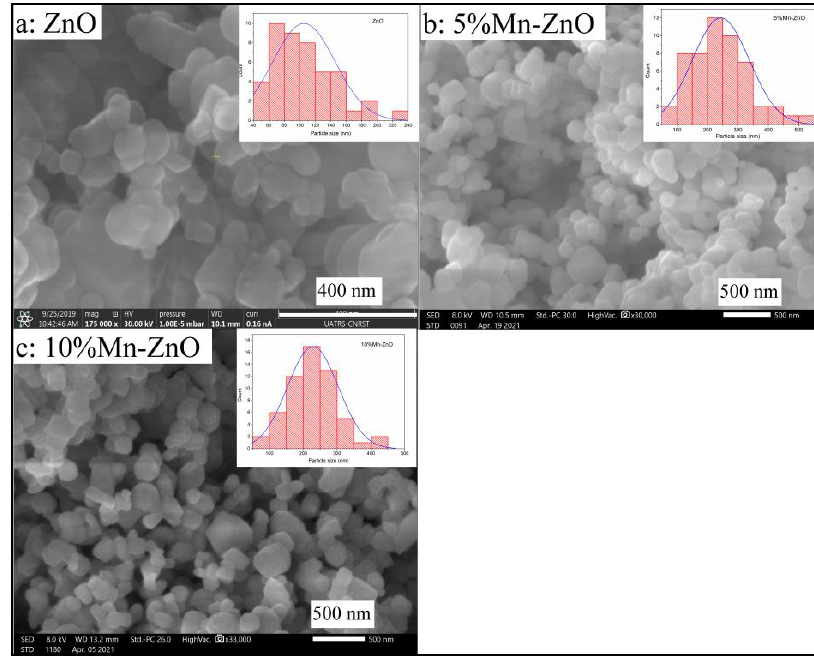
Figure 6. SEM images of ZnO ( a ), 5%Mn-ZnO ( b ) and 10%Mn-ZnO ( c )